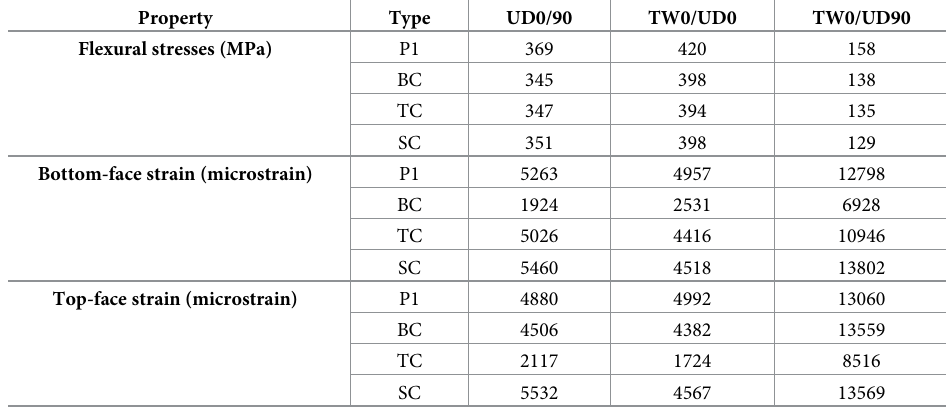
Table 4. Summary of important stress-strain parameters of SHC beams under four-point